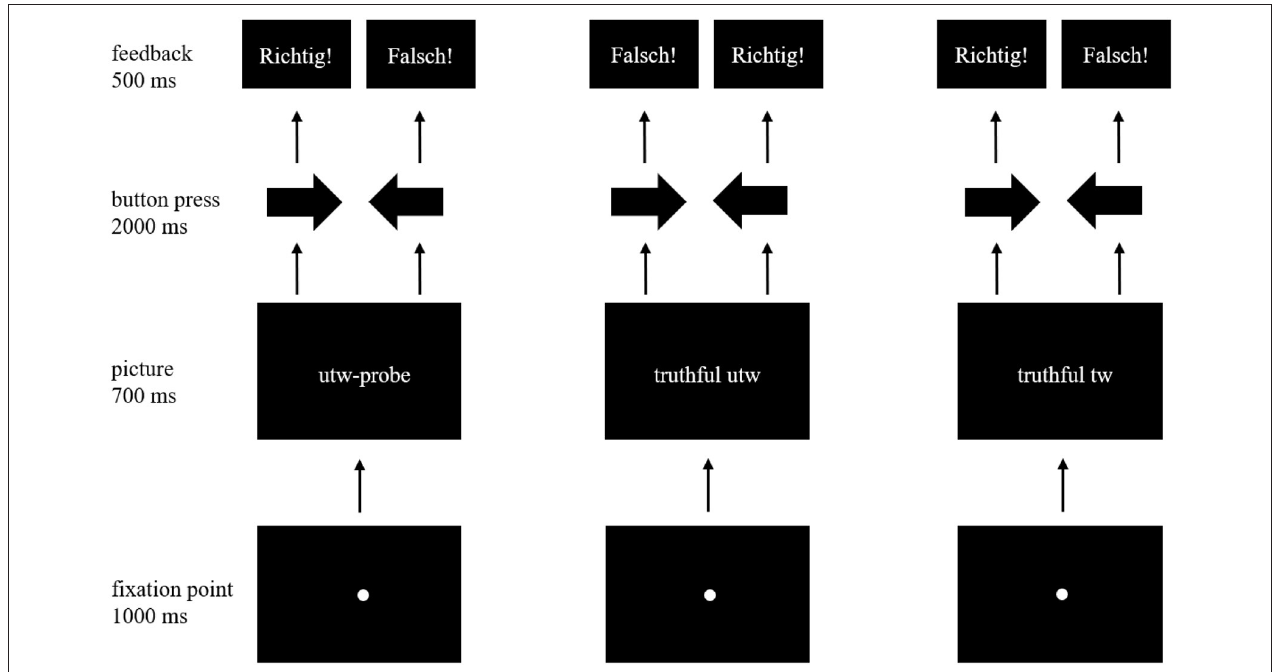
FIGURE 1 | Trial sequence for one item of each picture type (untrustworthy-probe, truthful untrustworthy, truthful trustworthy). The affective and neutral condition follow the same trial sequence and differ only in the stimulus material. For stimulus material please see Table 1 and the Chicago Face Database ( Ma et al., 2015). Inter-trial-intervals are not presented in this figure. The feedback “Richtig!” means “correct!” in German, “Falsch!” means “wrong!”.